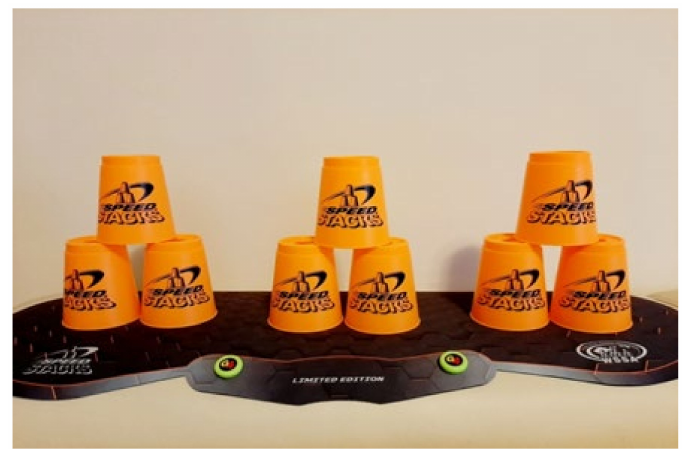
Figure 6. Form a pyramid from the cups on the right.